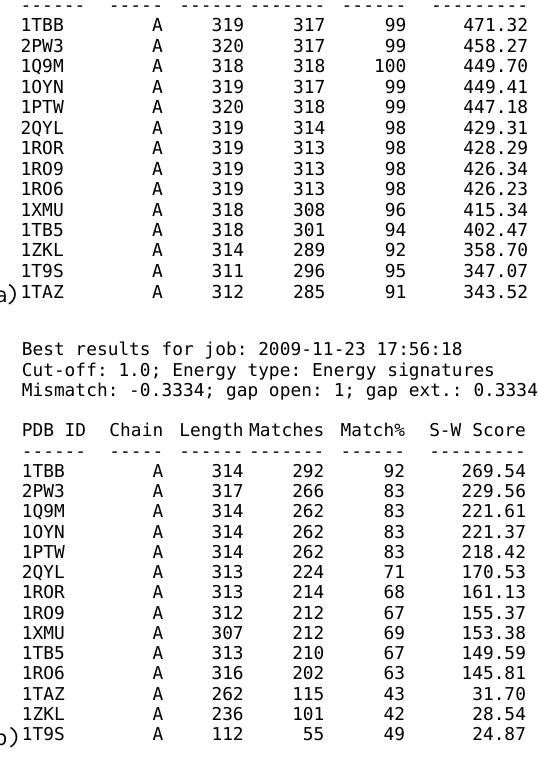
Fig. 16. Structural alignment of the query molecule 1TB7 and resultant molecule